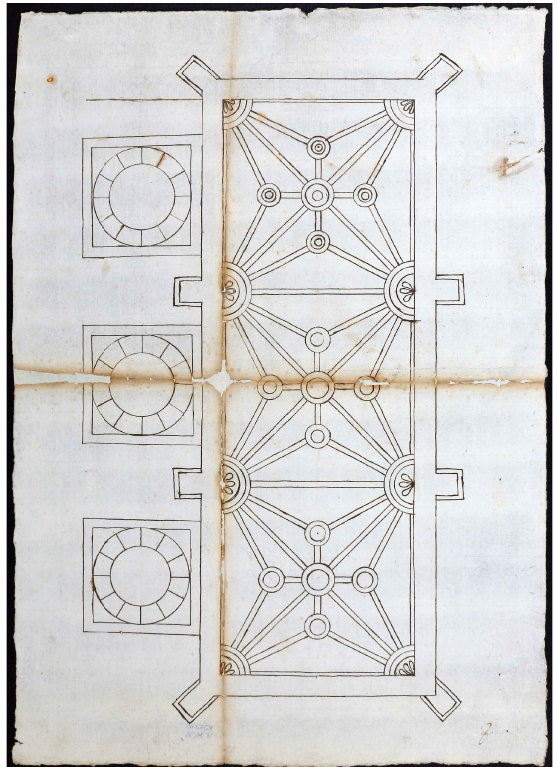
Figure 5. Project for the vaulting of the parish church of Castiello de Jaca (Huesca) [Archivo Histórico Provincial de Huesca (A.H.P.HU.), ES/AHPHU-MPGD/1/1]. © Archivo Histórico Provincial de Huesca.